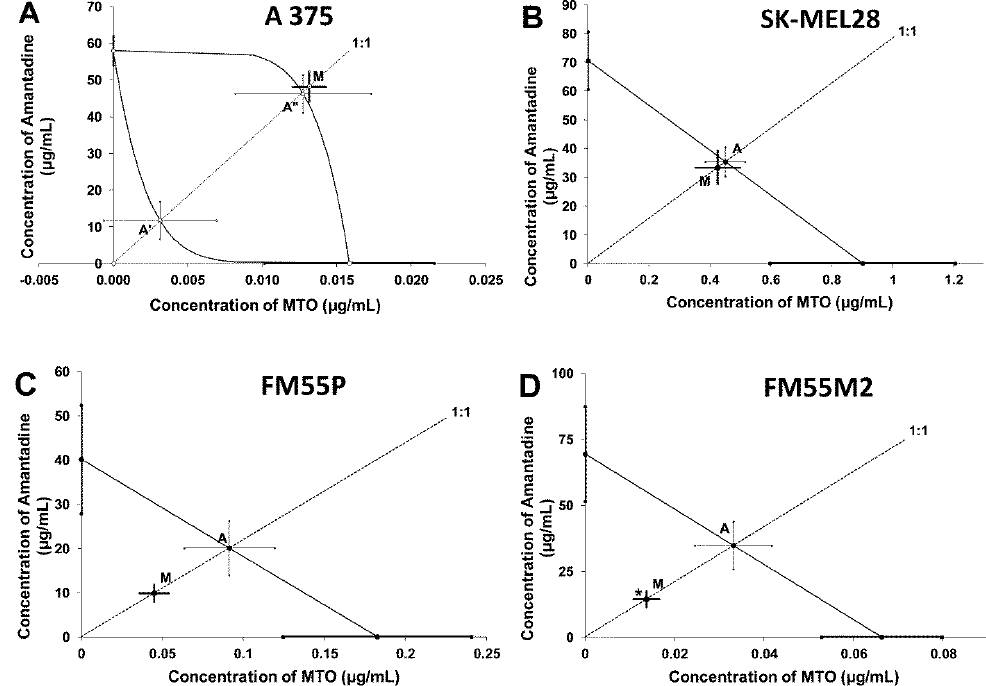
Figure 10. Isobolograms display additive and synergistic interactions between amantadine and mitoxantrone (MTO) with respect to their anti-proliferative effects on A375 ( A ), SK-MEL28 ( B ), FM55P ( C ) and FM55M2 ( D ) melanoma cell lines measured in vitro by the MTT assay. The IC 50 ± S.E.M. for amantadine and MTO are plotted on the X- and Y-axes, respectively. The points A, A (cid:48) and A (cid:48)(cid:48) depict the theoretically calculated IC 50add values ( ± S.E.M.). The point M on each graph represents the experimentally-derived IC 50exp value ( ± S.E.M.) for the mixture, which produced a 50% anti- proliferative effect in the malignant melanoma cell lines. * p < 0.05 vs. the respective IC 50add value (Student’s t -test with Welch correction). Point M is placed slightly above point A (cid:48) for the A357 cell line ( A ) indicating additivity between amantadine and MTO in the MTT assay. For the SK-MEL28 cell line, point M is placed between slightly below point A indicating additive interaction between amantadine and MTO ( B ). For the FM55P cell line ( C ), point M is placed below point A, indicating additive interaction for amantadine with MTO in the MTT assay. For the FM55M2 cell line ( D ), point M is placed significantly below point A (* p < 0.05), illustrating synergistic interaction between amantadine and MTO in the MTT